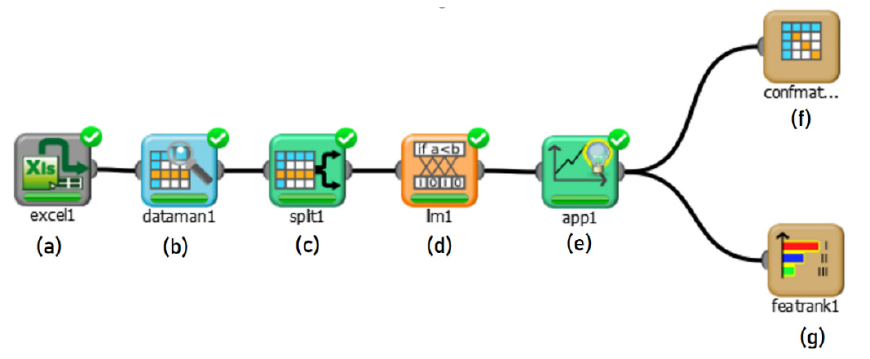
Figure 2. Rulex processing blocks: consisting of ( a ) excel1 which imports data, ( b ) dataman1 for viewing and data mining, ( c ) split1 for splitting dataset, ( d ) lm1 which performs the machine learning algorithm, ( e ) app1 to apply the model, and finally ( f ) confmatrix1 and ( g ) featrank1 which visually display results [3].